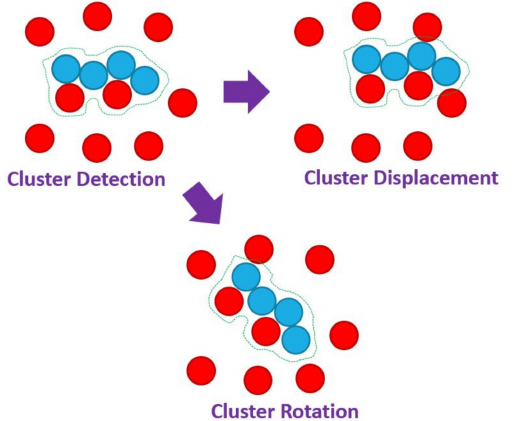
Figure 2. Schematic representation of the cluster displacement (CluDis) and cluster rotation (CluRot) moves in a mixed system of chain ( blue ) and single ( red ) monomers. The initial step of cluster detection is performed based solely on proximity criterion. The identified cluster is shown by the contour line. The cluster, as a whole unified group of monomers, can then be displaced in a random direction and length (ClusDis) or be rotated by a random amount around its center of mass (ClusRot).